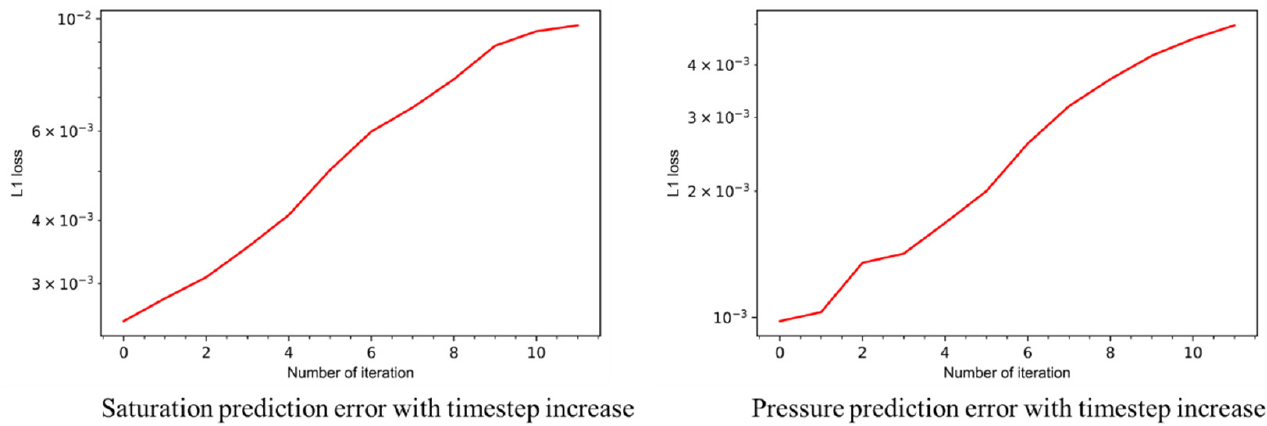
Figure 18. The prediction error for recurrently predicting saturation and pressure fields. Moreover, the prediction speed of our method is still much faster than that of the numerical simulator, as shown in Figure 20, and even faster for the larger geological model. On the other hand, the history fitting process can be done automatically by our method, which further saves the time needed for prediction